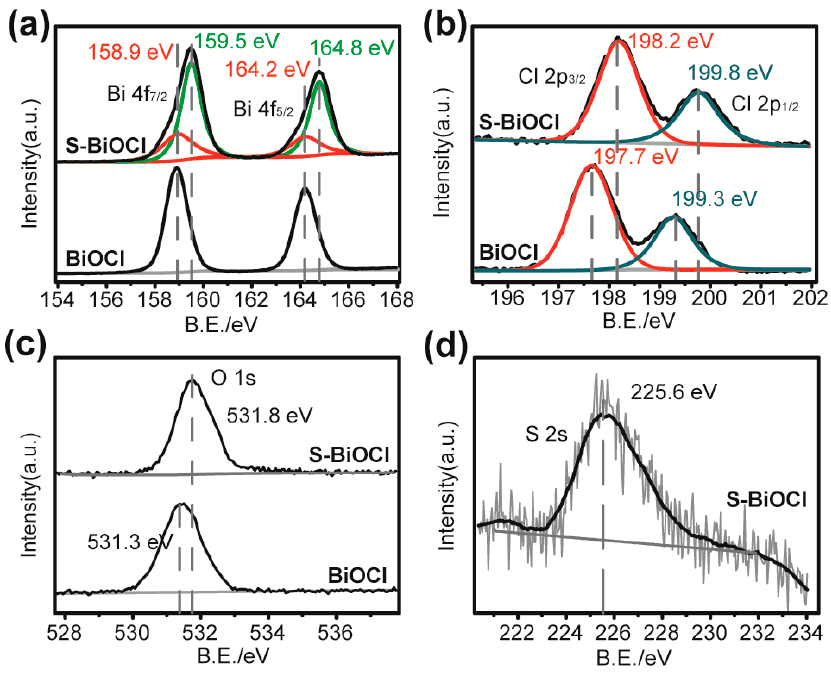
Figure 3. ( a ) Bi 4f XPS spectra, ( b ) Cl 2p XPS spectra, and ( c ) O 1s XPS spectra of S-BiOCl and commercial BiOCl. ( d ) S 2s XPS spectra of S-BiOCl.